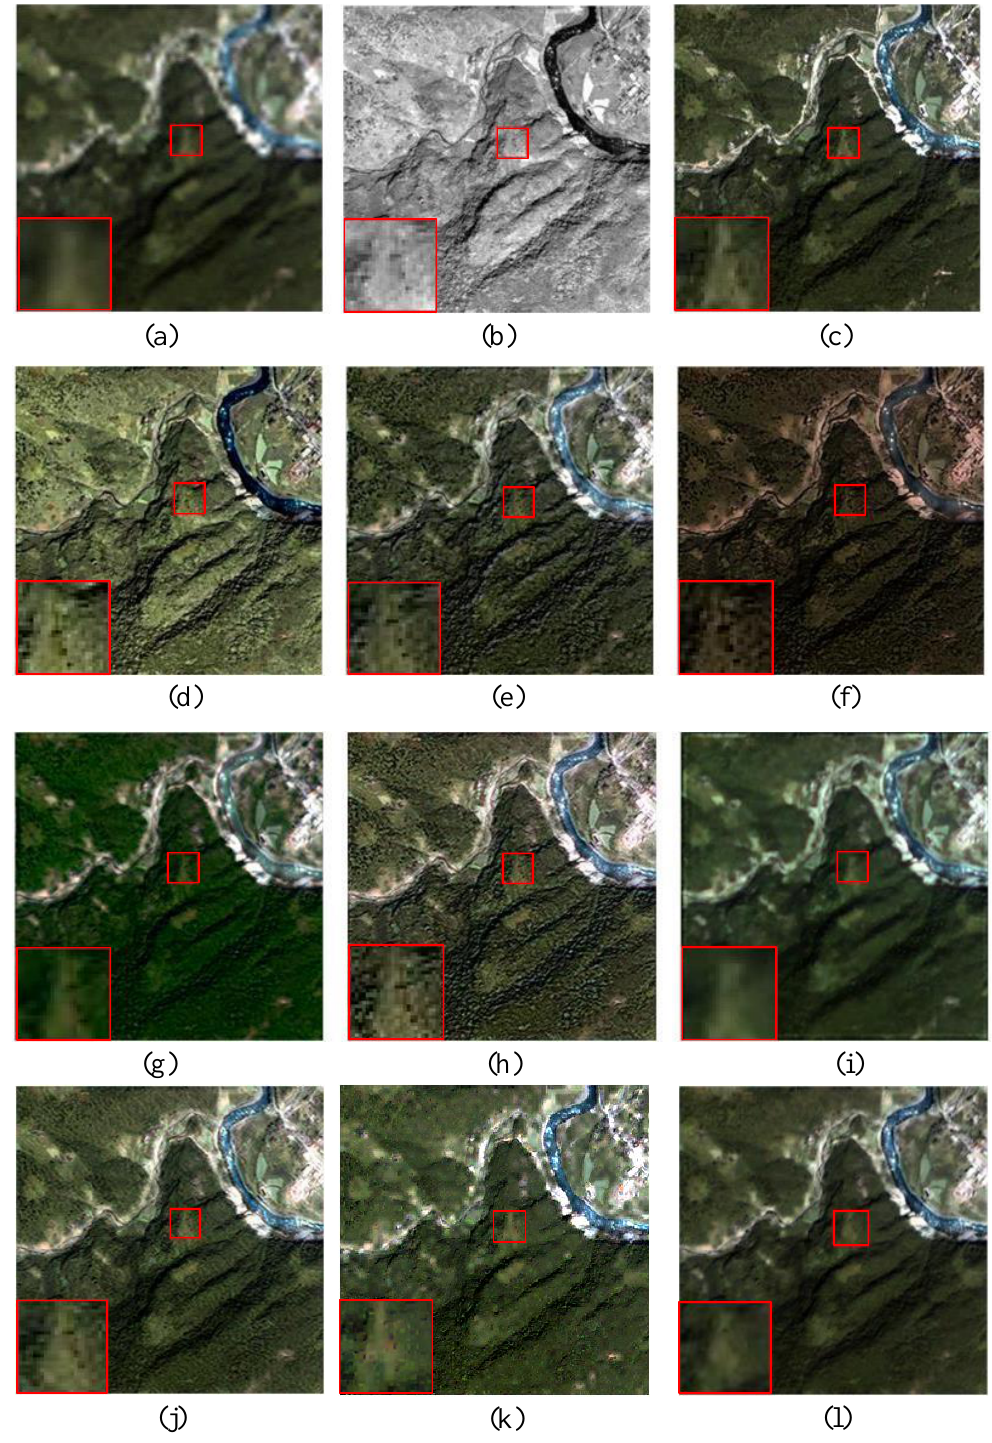
Figure 9. The fused results on the simulated IKONOS dataset. ( a ) LR-MS. ( b ) PAN. ( c ) The ground truth. ( d ) GS. ( e ) Indusion. ( f ) SR. ( g ) PNN. ( h ) PanNet. ( i ) MSDCNN. ( j ) MIPSM. ( k ) GTP-PNet. ( l )